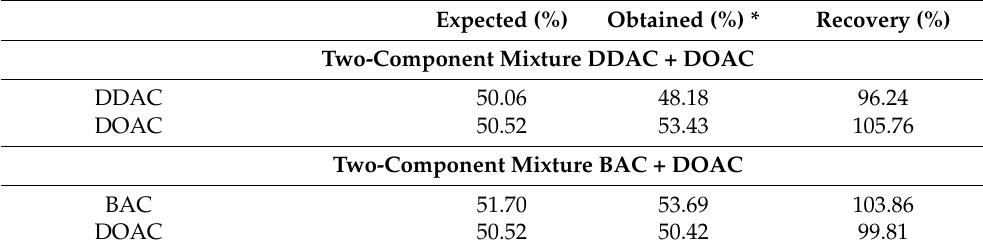
Table 6. Results of potentiometric determination of the content of cationic surfactants in two- component model mixtures containing DDAC + DOAC, and BAC and DOAC.